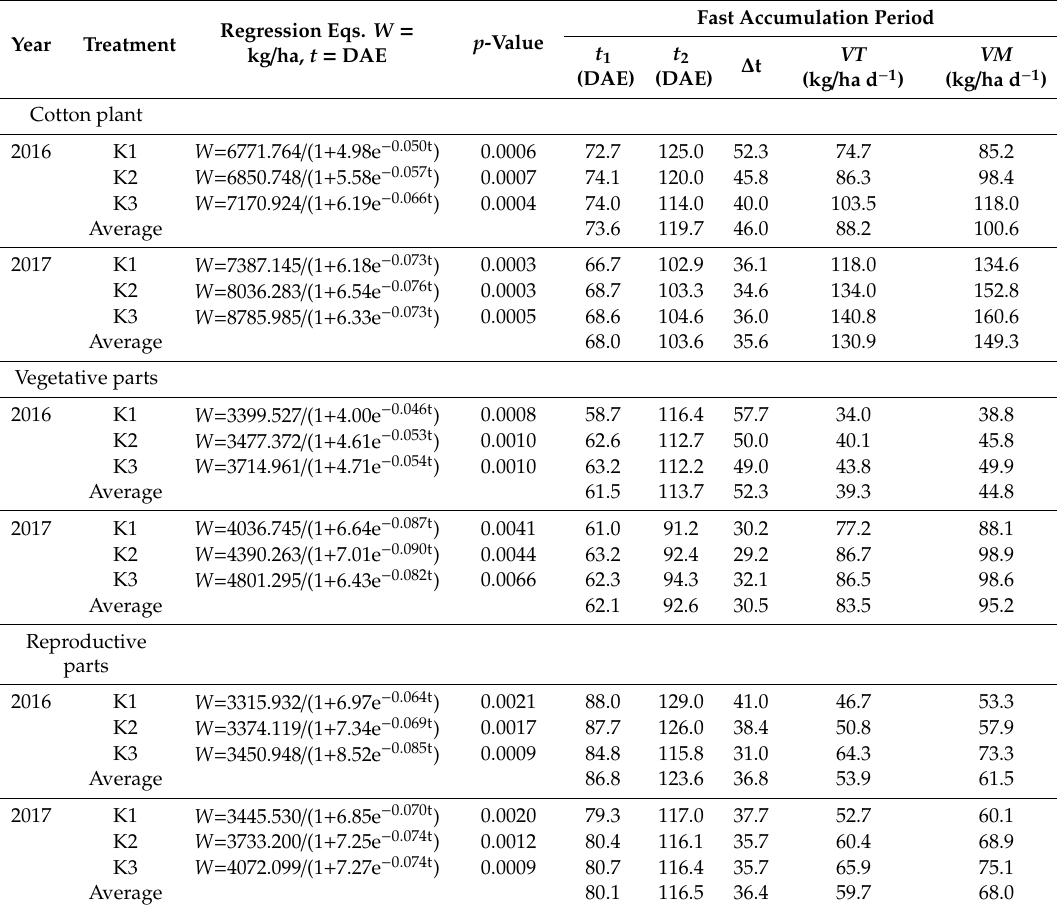
Table 3. Regression equation and Eigenvalues of cotton plant biomass accumulation of field-grown cotton influenced by K fertilizer amount in 2016 and